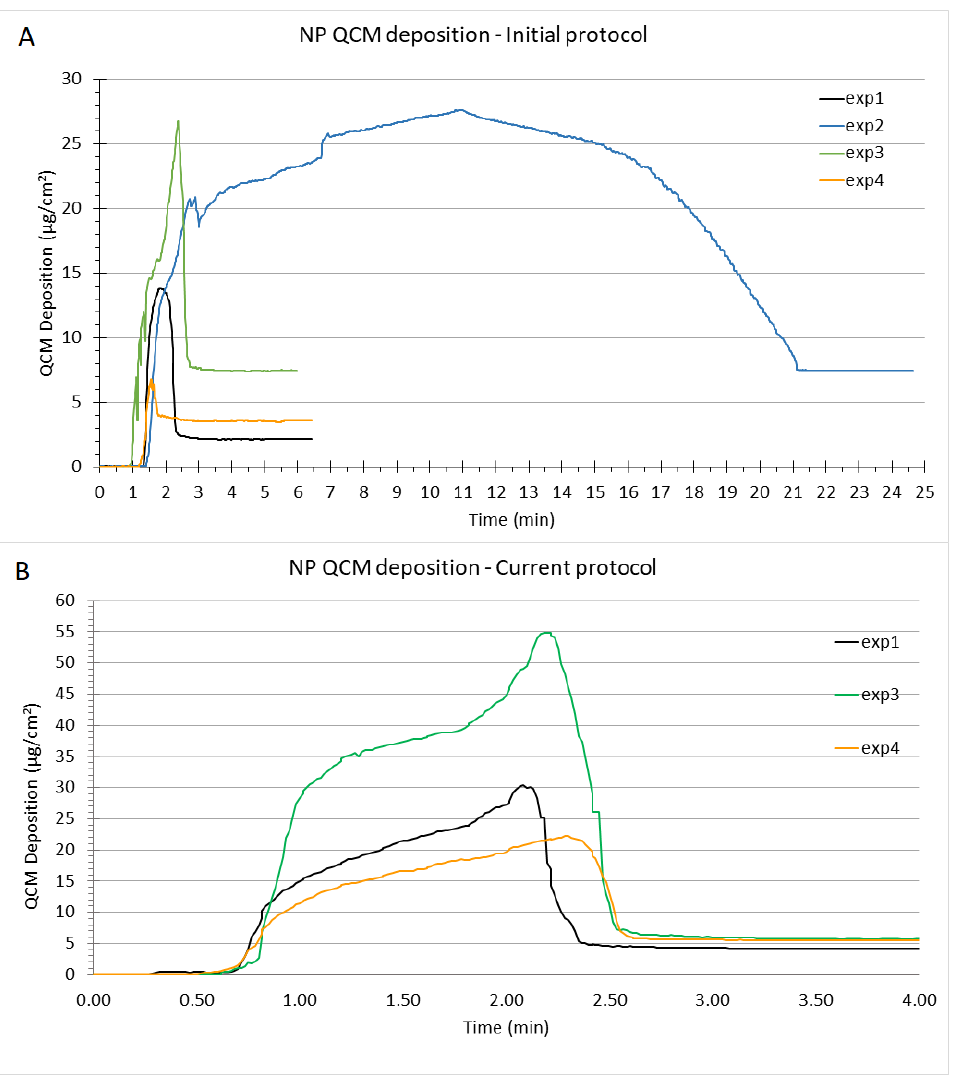
Figure 6. QCM curves showing in the first part the dynamics of cloud deposition in the VITROCELL ® Cloud System followed by an asymptotic (constant) value, which represents the mass of the deposited TiO 2 NPs. The nebulization starts between 30 s and 1 min after the start of data acquisition. Depicted are ( A ) the four NP exposures following the initial protocol (57 µL of TiO 2 NP at 30 mg/mL); ( B ) three exposures following the current protocol (114 µL of TiO 2 NP at 15 mg/mL), the second nebulization (exp2) is not shown because of data backup failure (see Table